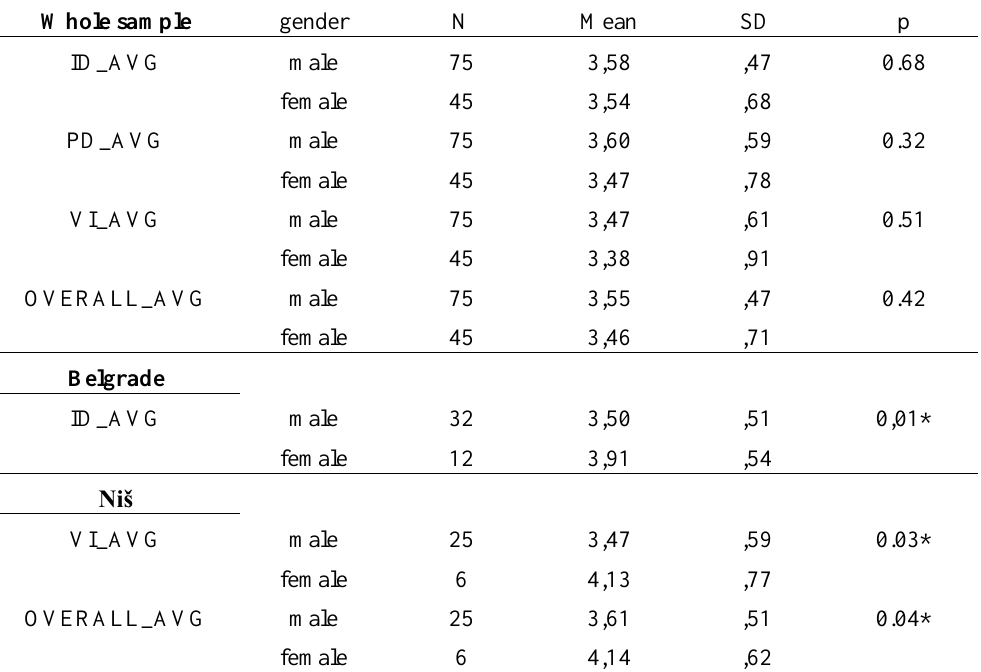
TABLE 4 Results of t-test for independent samples regarding gender differences in whole sample and significant of the